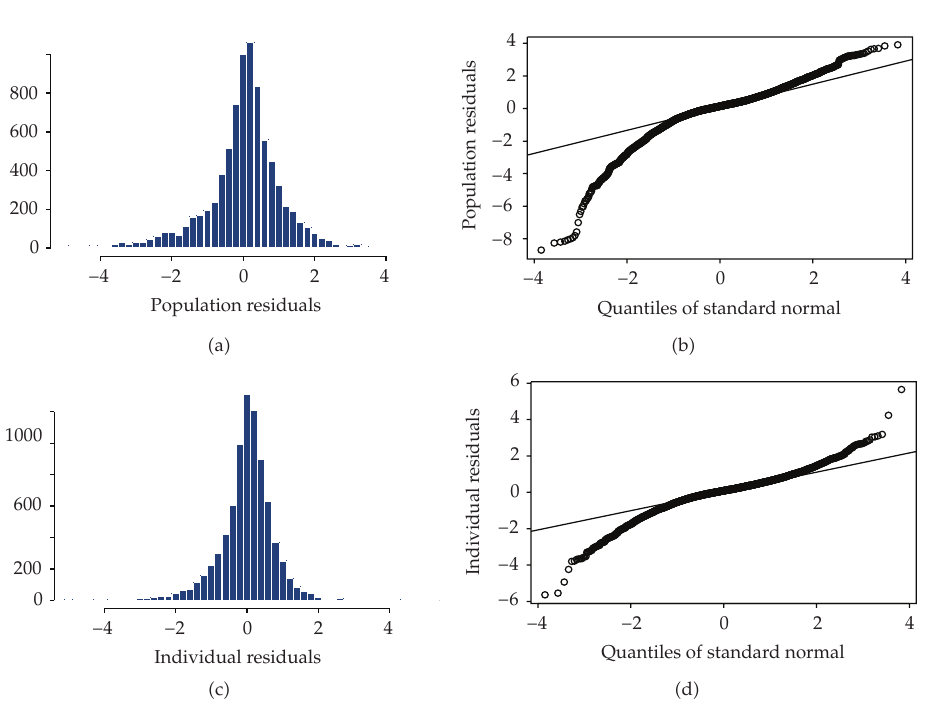
Figure 4: Histograms and normal-quantile plots for population residuals (cid:3) a,b (cid:4) and individual residuals (cid:3) c,d (cid:4) .